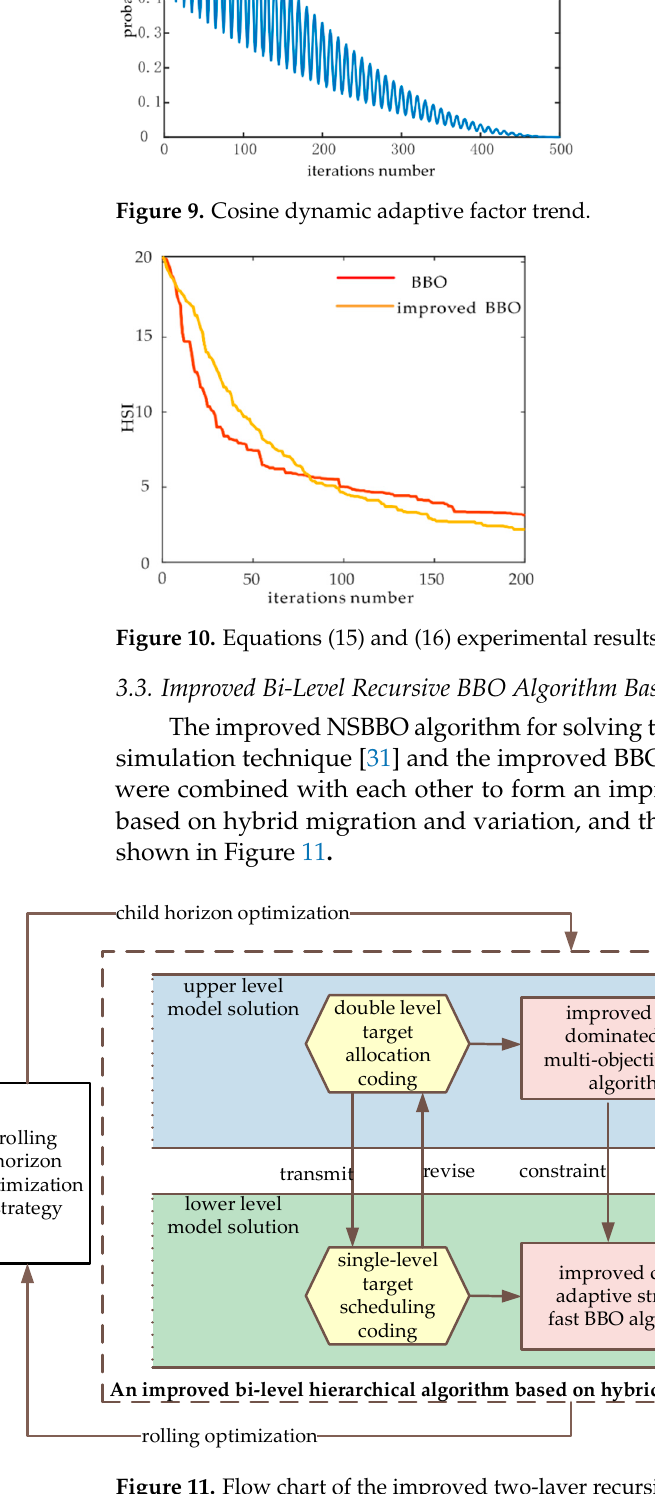
Figure 9. Cosine dynamic adaptive factor trend.